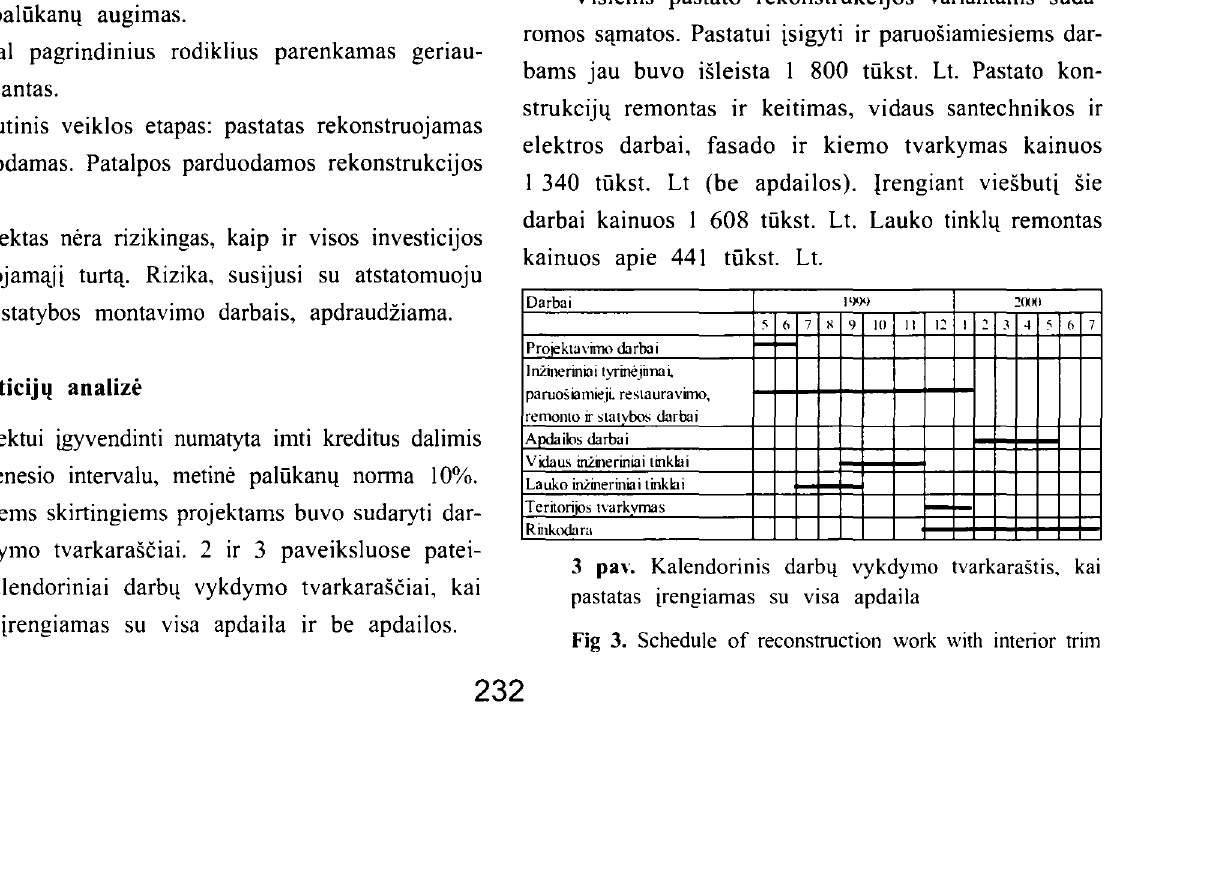
Fig 2. Model of building reconstruction marketing Visiems pastato rekonstrukcijos variantams suda romos S<tmatos. Pastatui isigyti ir paruosiamiesiems dar barns jau buvo isleista I 800 tiikst. Lt. Pastato kon strukcijq remontas ir keitimas, vidaus santechnikos ir elektros darbai, fasado ir kiemo tvarkymas kainuos I 340 tiikst. Lt (be apdailos). {rengiant viesbuti sie darbai kainuos I 608 tiikst. Lt. Lauko tinklq remontas kainuos apie 441 tiikst. Lt.